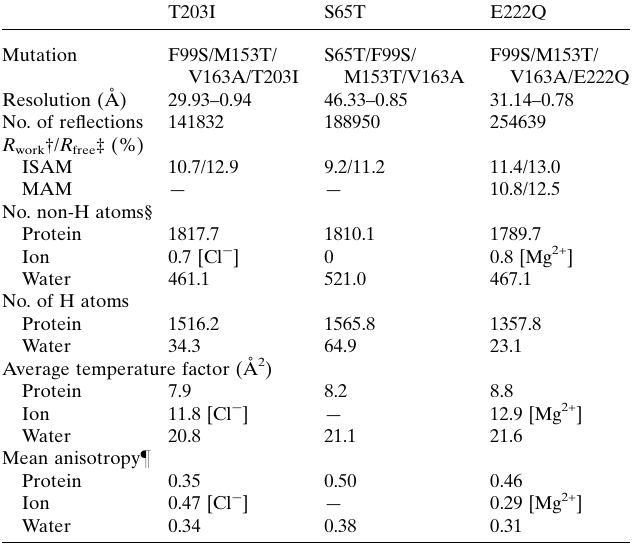
Table 2 Refinement